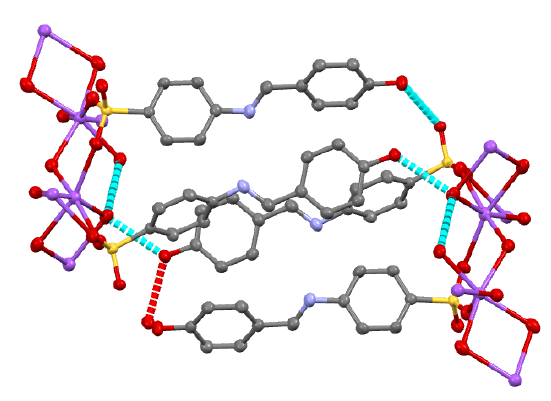
Figure 5: The hydrogen bonds in Na(I) coordination polymer.